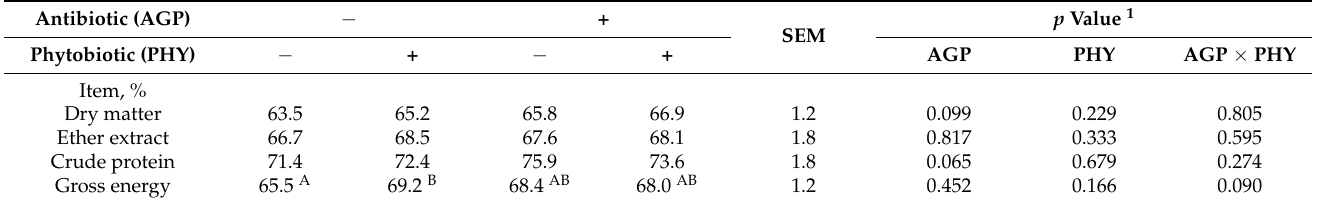
Table 9. Apparent ileal digestibility of nutrients in nursery pigs fed diets supplemented with phytobiotics and antibiotics as growth promoters (Exp.